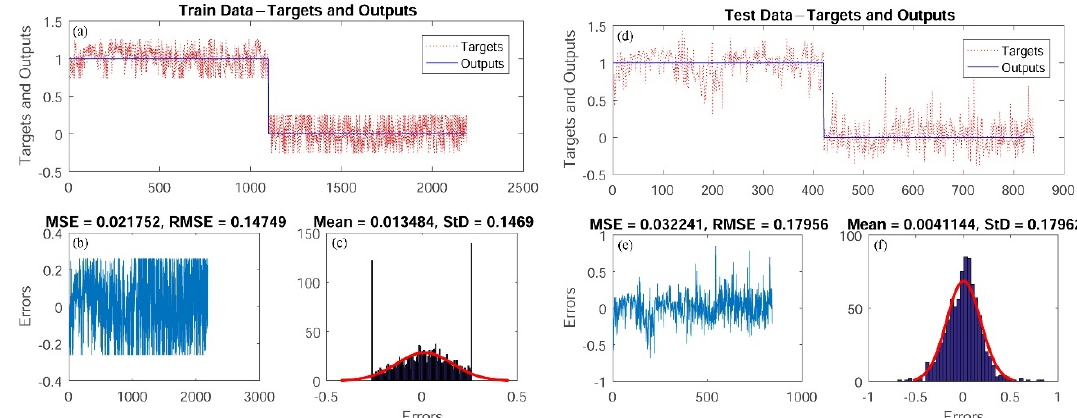
Figure 9. SVR-FA model: ( a ) target and output SVR-FA value of training data samples, ( b ) MSE and RMSE value of training data samples, ( c ) frequency errors of training data samples, ( d ) target and output SVR-FA value of testing data samples, ( e ) MSE and RMSE value of testing data samples, ( f ) frequency errors of testing data samples.